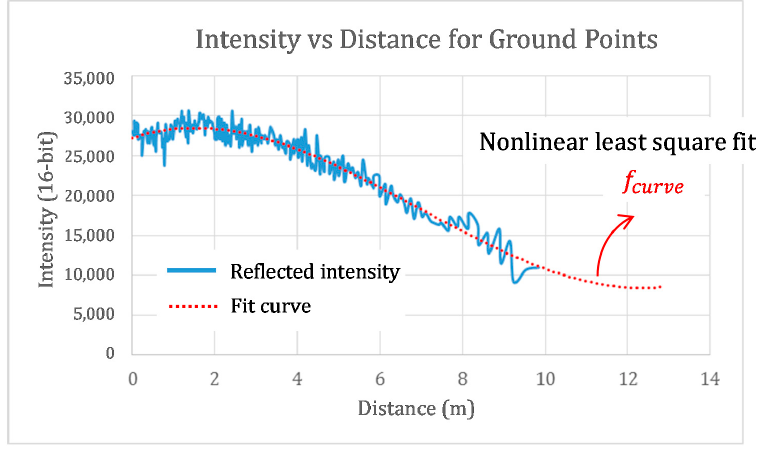
Figure 10. Effect of the increase of the distance to the reflected intensity value of the asphalt surface. By increasing distance, the angle of incidence inherently decreases. The red curve illustrates the curve fit to the relation between distance and intensity using a nonlinear least squares fitting method.